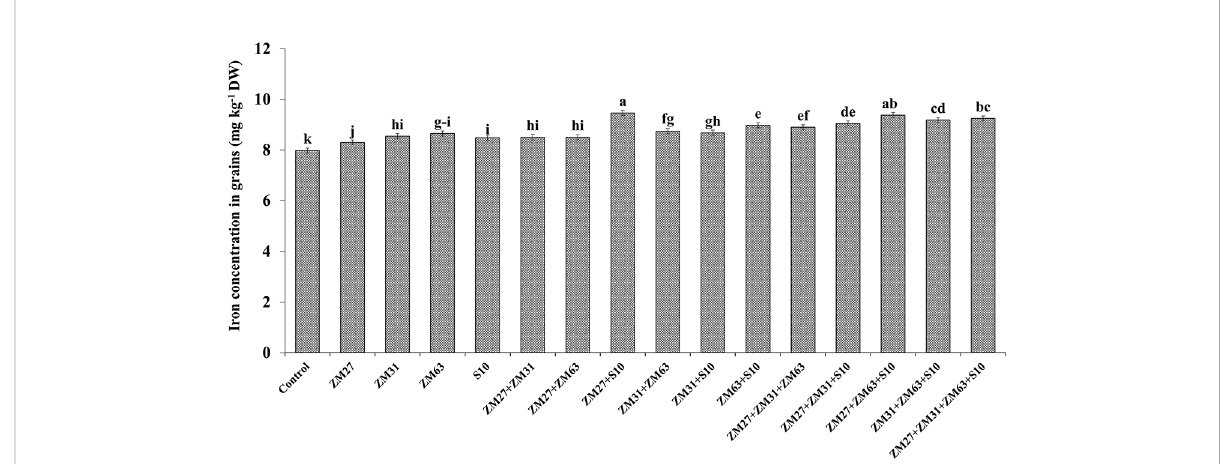
FIGURE 1 Effect of PGPR inoculation on shoot iron contents in maize in the pot trial. The bars with different letters are signi fi cantly different at p ≤ 0.05.